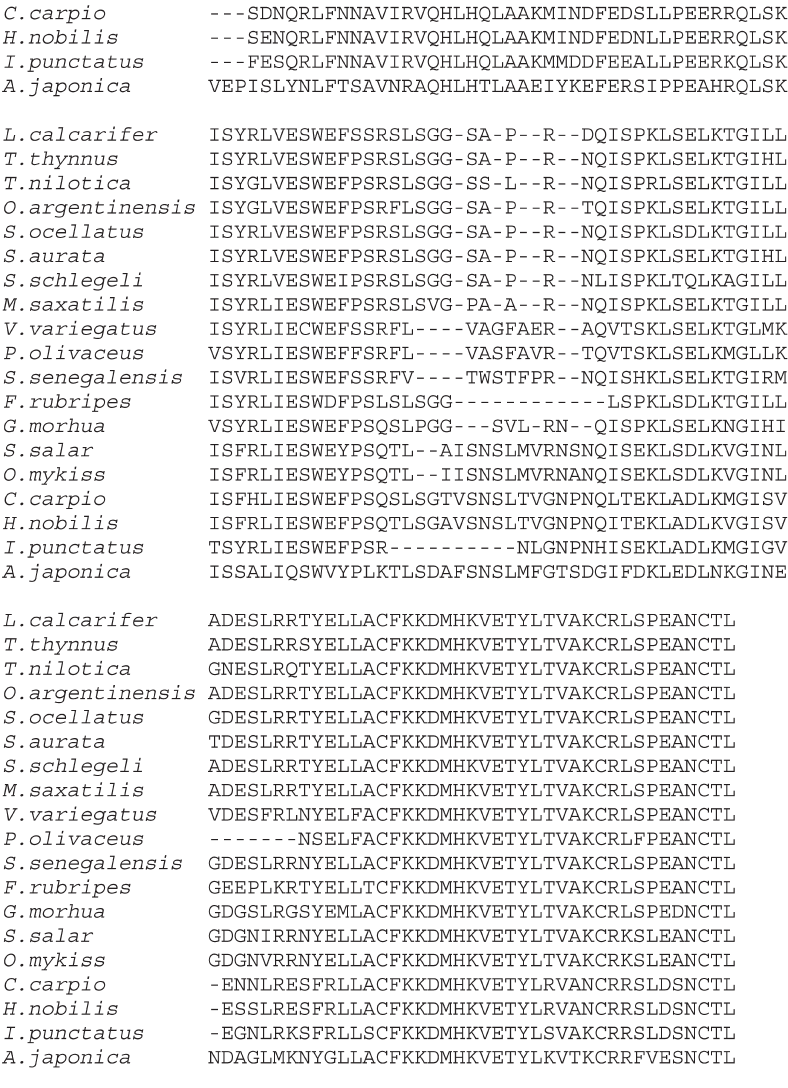
Figure 2 - Comparison of the primary amino acid sequences from various fish GHs. The GH sequences included in this analysis are T. nilotica (Genbank accession AAA49437), L. calcarifer (Genbank accession AAC59692), S. ocellatus (Genbank accession AAC63266), M. saxatilis (Genbank accession AAB34389), T. thynnus (Sato et al ., 1988), S. aurata (Funkenstein et al ., 1991), S. schlegeli (Genbank accession AAB49492), P. olivaceus (Momota et al ., 1988), V. variegatus (Genbank accession AAC36716), S. senegalensis (Genbank accession AAA60372), F. rubripes (Venkatesh and Brenner,